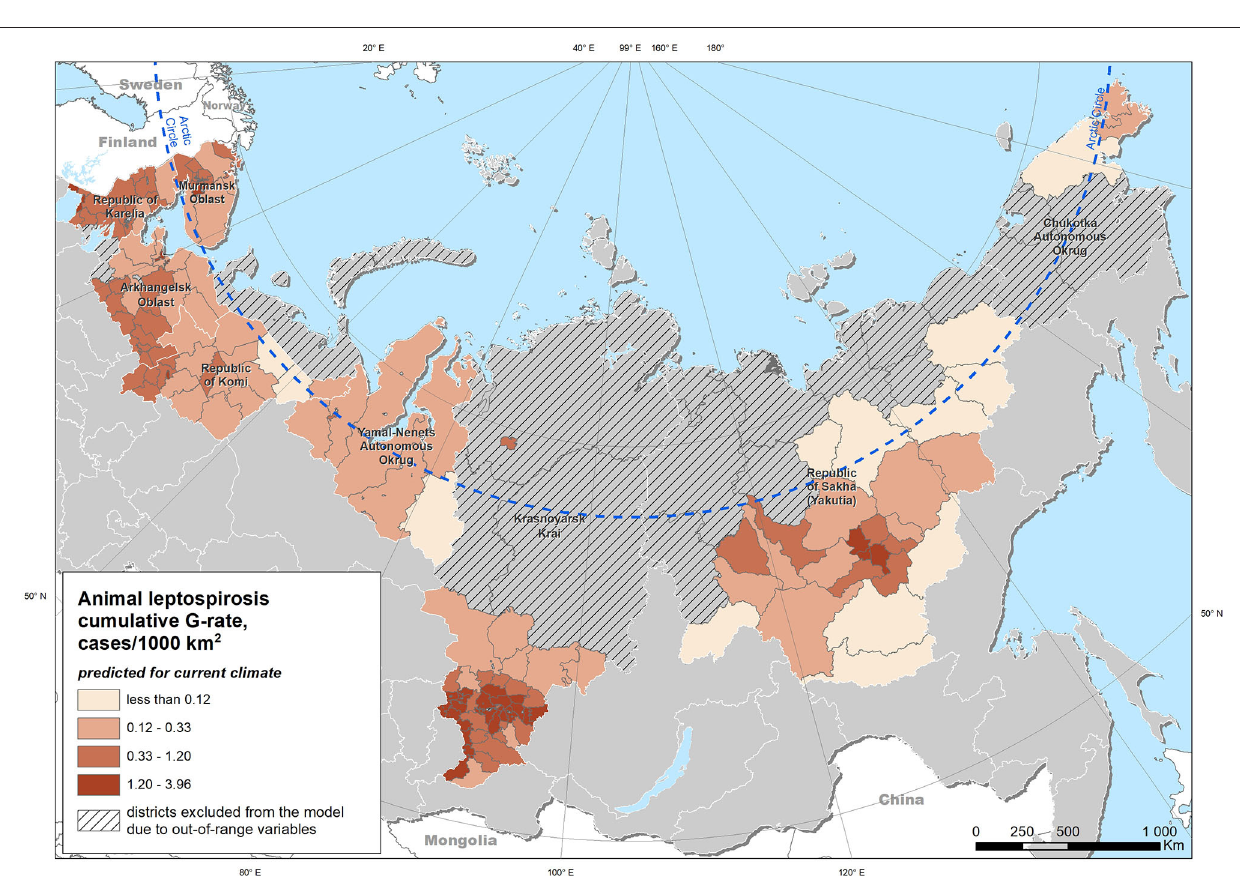
FIGURE 5 | Distribution of the predicted density of leptospirosis cases (G-rate) under the current climate